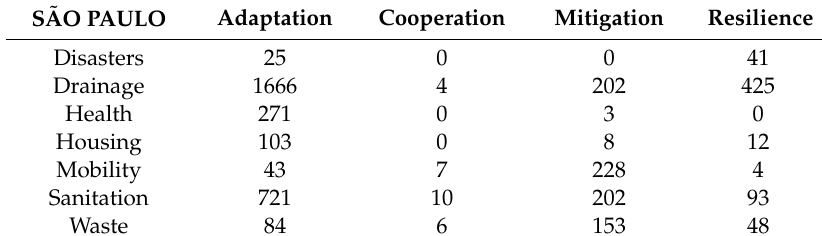
Figure 13. Climate action references in Salvador’s sectoral plans. Table 13. Climate action references in São Paulo’s sectoral plans.